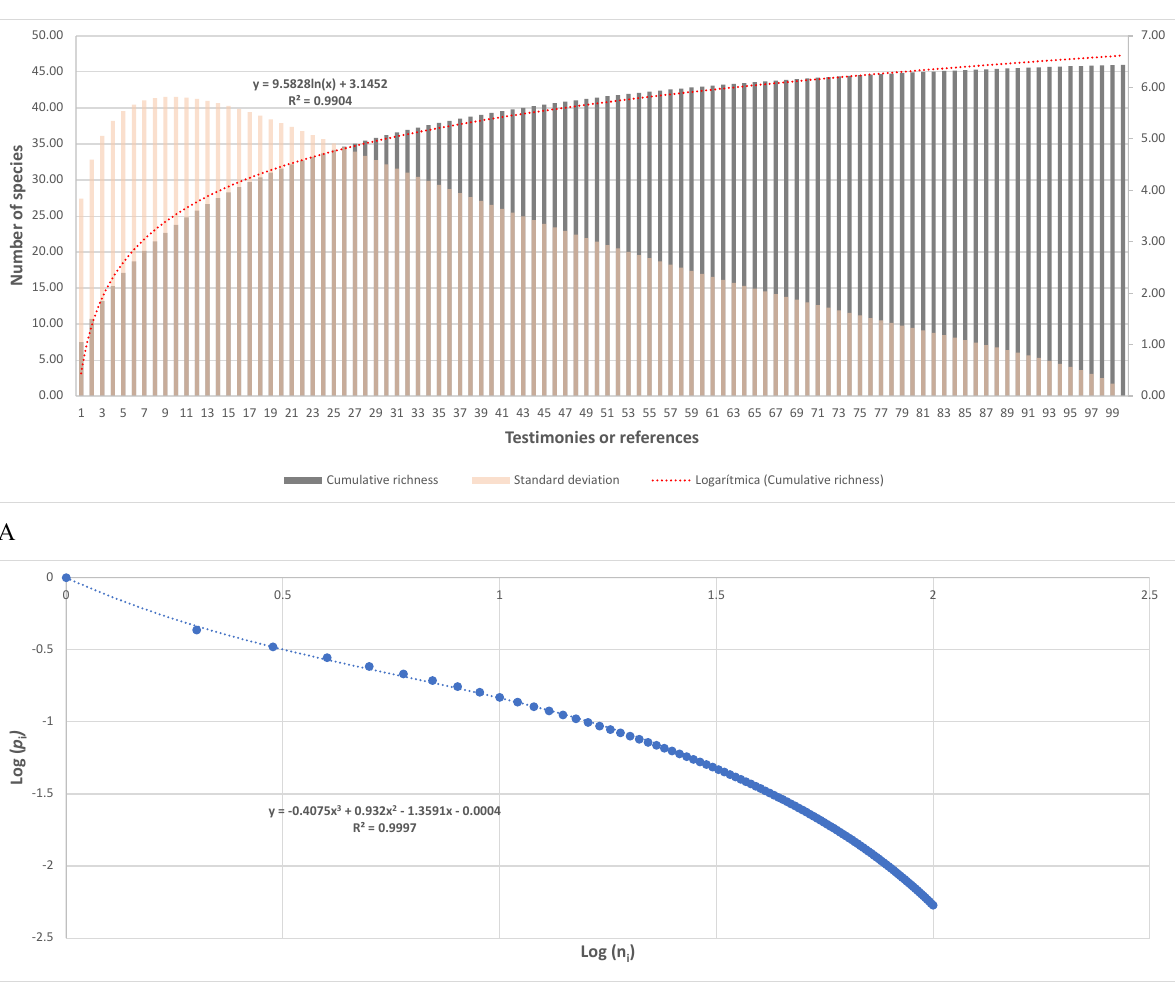
Figure 3. Basis to test representativity of sample to estimate the cumulative richness of edible entomofauna. A) Cumulative species and standard deviation estimated by permutations of 100 data. B) Probability function of new species according to size-sample (logarithmic